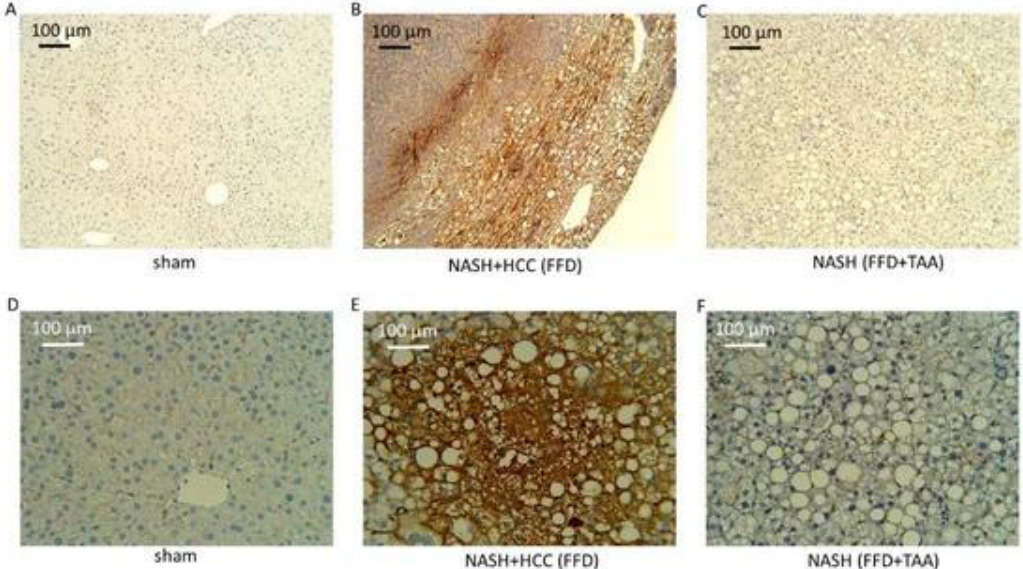
Figure 6. HCC. ( A – C ) Representative liver sections (10 × ) from Ca-19-9-stained sham, FFD and FFD+TAA groups. Staining is enriched in the FFD liver indicative of HCC. This liver bore a large tumor at sacrifice. ( D – F ) Representative liver sections (25×) from cytokeratin-7-stained sham, FFD and FFD+TAA groups. Staining is enriched in the FFD liver, indicative of HCC. This liver bore several tumors at sacrifice.